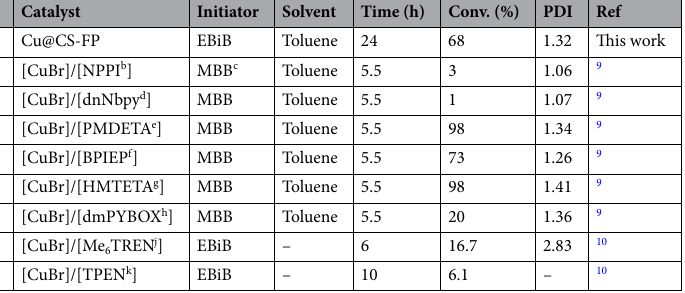
Table 2. Comparison of the results obtained from Cu@CS-FP with various types of copper-based catalysts for the ATRP reaction of methyl methacrylate. a Polymerization conditions: 90 °C. b NPPI: N -( n -propyl)-2- pyridylmethanimine. c MBB: 3-Bromo-3-methyl-butanone-2. d dnNbpy: 4,4 ′ -Di ( n -nonyl) 2,2 ′ -bipyridine. e PMDETA: N,N,N ′ ,N ′ ,N ′ ′ -pentamethyldiethylenetriamine. f BPIEP: 2,6-Bis[1-(2,6-diisopropylphenylimin odiisopropylphenylimino)ethyl]pyridine. g HMTETA: ( N,N, N,N,N,N -hexa methyltriethylenetetramine). h dmPYBOX: 2,6-Bis(4,4-dimethyl-2-oxazolin-2-yl)pyridine. i Polymerization conditions: 70 °C. j Me Tris[2-(dimethylamino) ethylamine. k N,N,N ′ ,N ′ -tetrakis(2-pyridylmethyl)